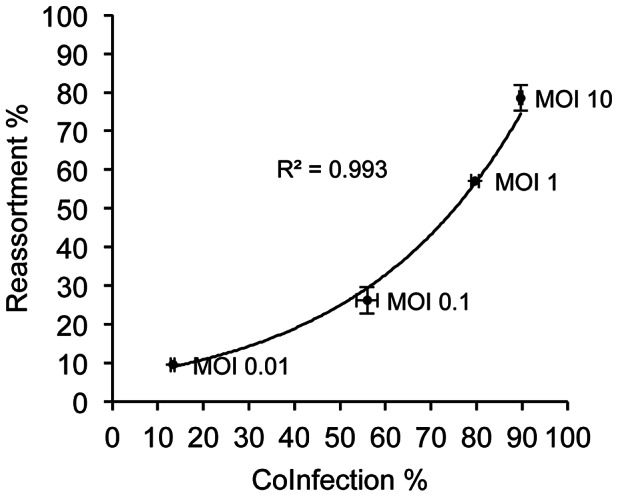
Frequency of reassortment increases exponentially with frequency of co-infection.MDCK cells were infected simultaneously at the indicated MOIs with rPAN/99wt and rPan/99var viruses carrying His and HA tags, respectively. At 12 h post-infection, cells were collected for flow cytometric analysis to determine co-infection frequency and cell culture medium was collected for genotyping of released virus. To prevent multiple cycles of replication, infections were performed in the absence of trypsin. Average values (n = 2 cell culture dishes) +/− standard deviation are shown. The coefficient of determination (R
2) value indicates how well the exponential trend line fits the data.